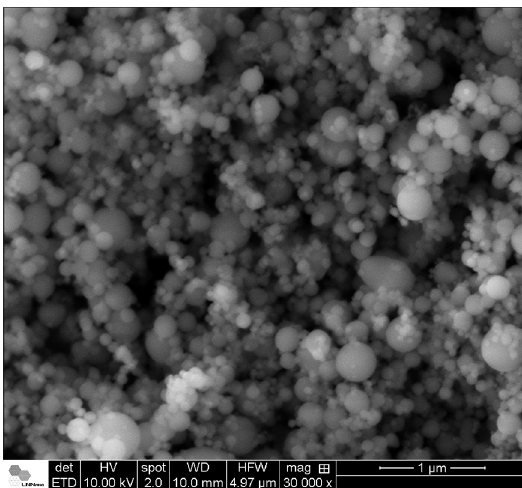
Figure 7. SEM image obtained for active silica particles.